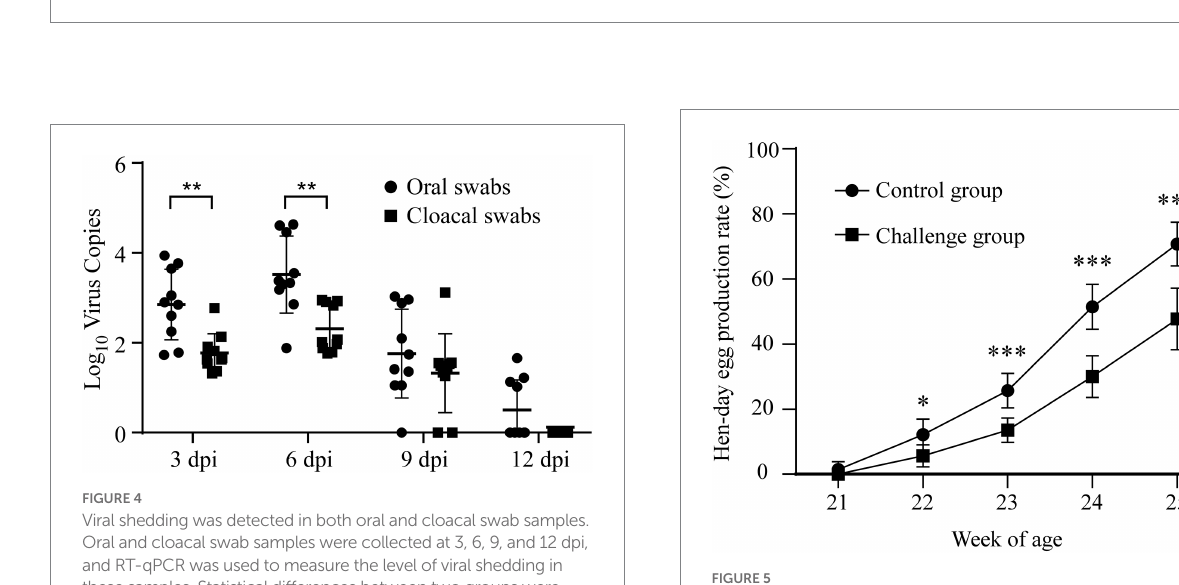
FIGURE 3 Viral load in different tissues of chickens at 3, 6, 9, and 12 days post infection. The trachea, lung, spleen, kidney, and bursa of Fabricius samples were collected at 3, 6, 9, and 12 dpi, total RNA was extracted and reverse transcribed into cDNA, and RT–qPCR was used to measure the viral load in different tissues. LOD: limit of detection.